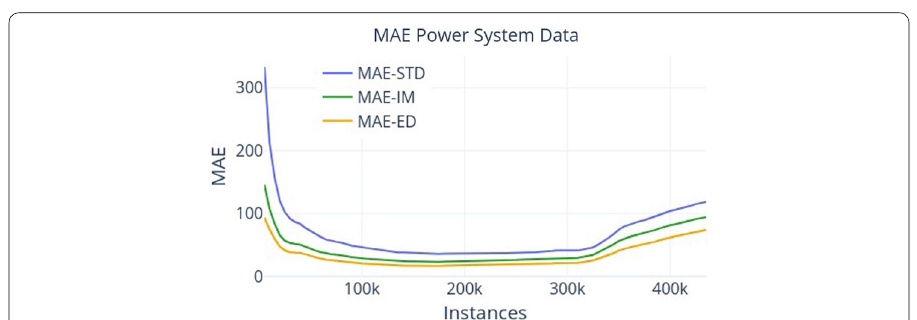
Fig. 3 MAE comparison of the power system